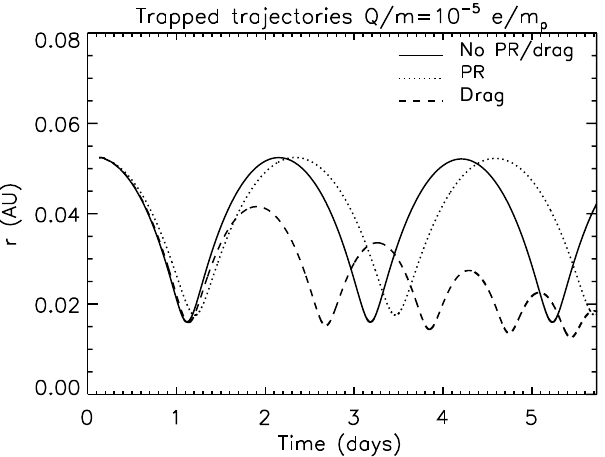
Figure 17. Effect of the (photon) Poynting–Robertson force and the plasma drag force on a trapped particle trajectory. While the Poynting–Robertson force leaves the minimum and maximum r val- ues almost unaffected, the plasma drag causes them to decrease with time. The decrease in minimum r may lead to crossing of the lower boundary of the calculational domain and/or destruction of the nan- odust particle by